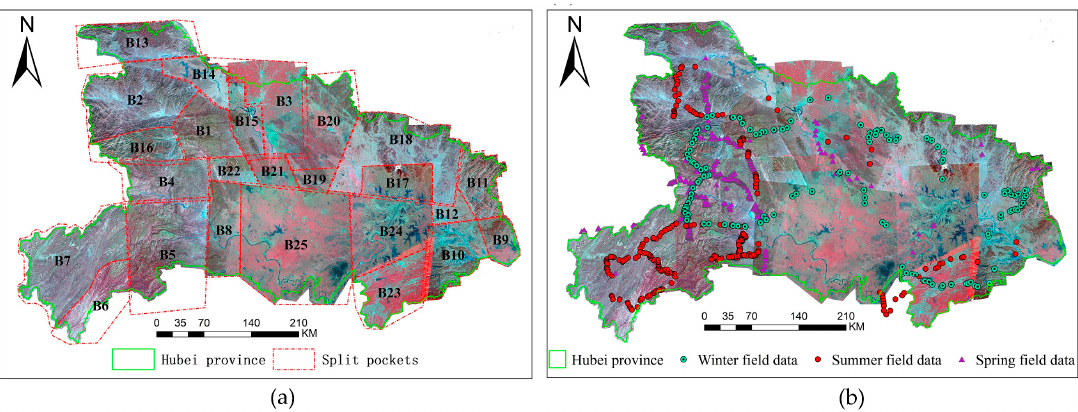
Figure 2. Divided splits of the study site ( a ) and the spatial distribution of the field samples in spring, summer, and winter ( b